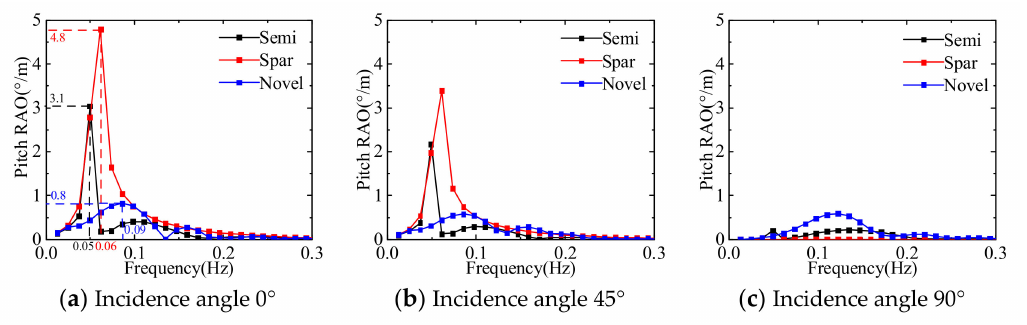
Figure 23. Comparison of the response amplitude operator in roll direction of three floating platforms.